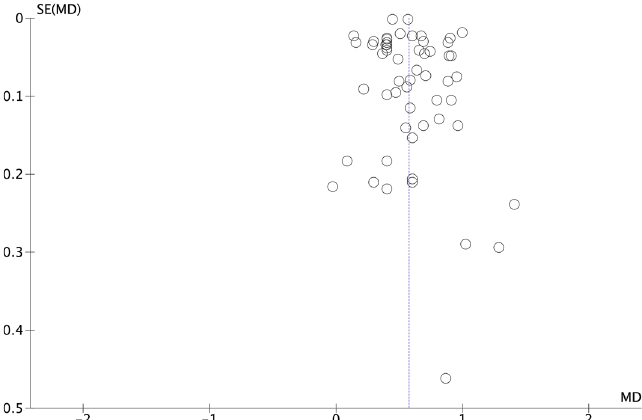
Figure 5. Funnel plot (meta-analysis 1).